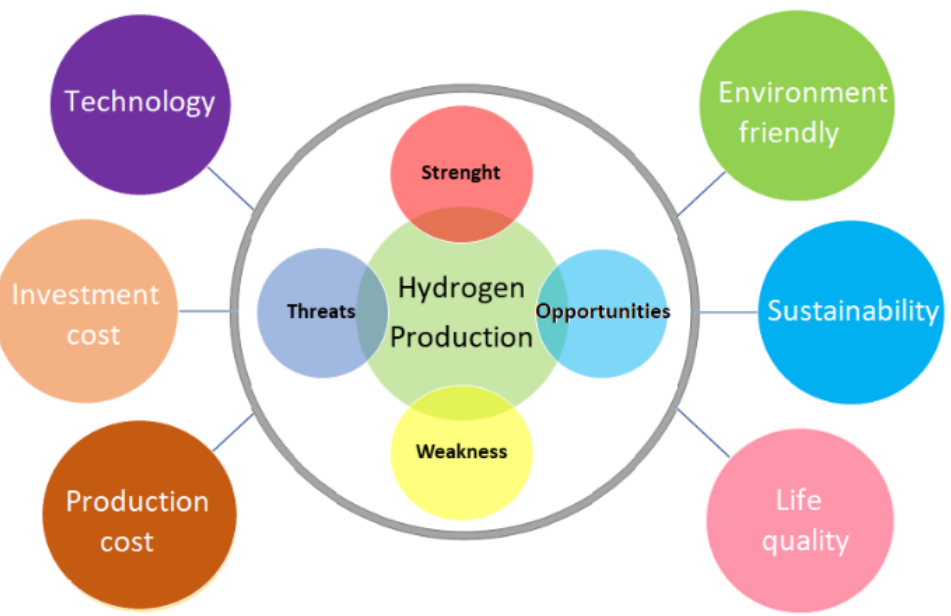
Figure 4. Scheme of the technical and economic analyses of the hydrogen production.